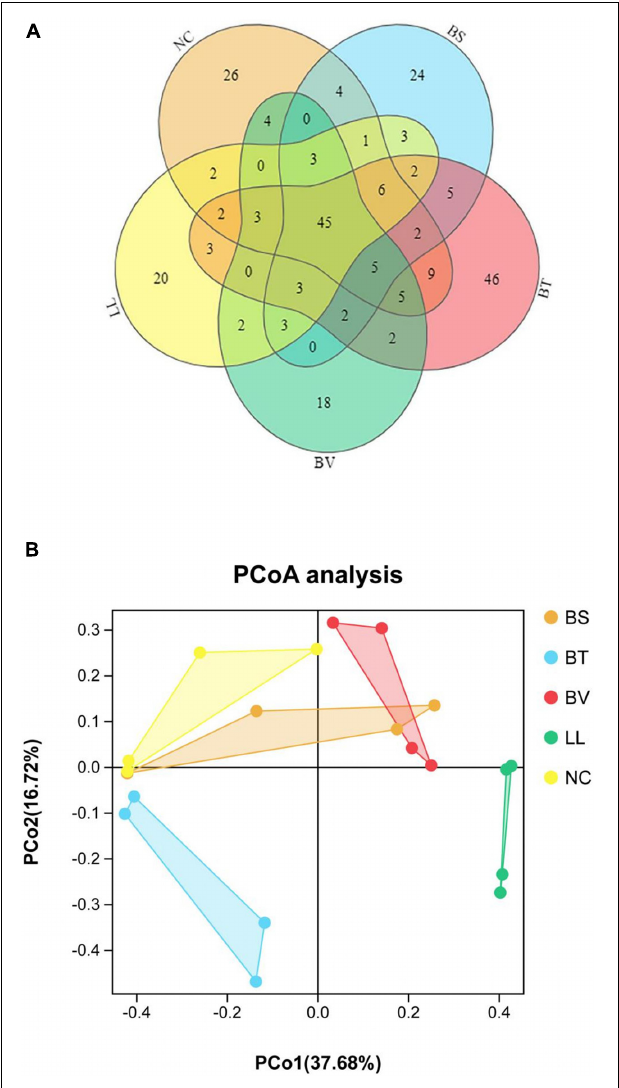
FIGURE 5 | (A) Venn diagram and (B) principal component analysis (PCoA) based on Jaccard distance matrix of jejunal microbiota. NC, control diet; BS, control diet containing 1 × 10 7 CFU/g of Bacillus siamensis ; BT, control diet containing 1 × 10 7 CFU/g of Bacillus tequilensis ; BV, control diet containing 1 × 10 7 CFU/g of Bacillus velezensis ; and LL, control diet containing 1 × 10 7 CFU/g of Lactococcus lactis